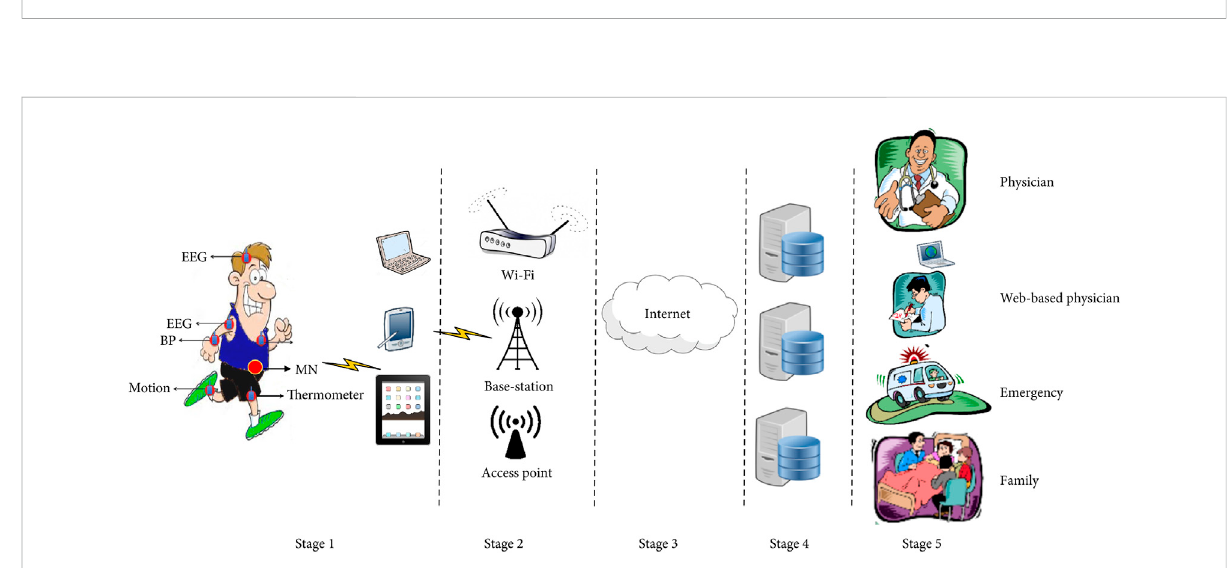
FIGURE 10 Wireless sensor body networks for IoT-based healthcare applications (Alkhayyat et al., 2019).